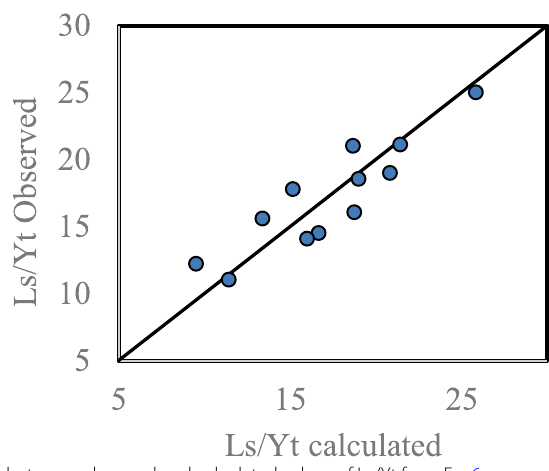
Fig. 9 Relationship between observed and calculated values of Ls/Yt from Eq.